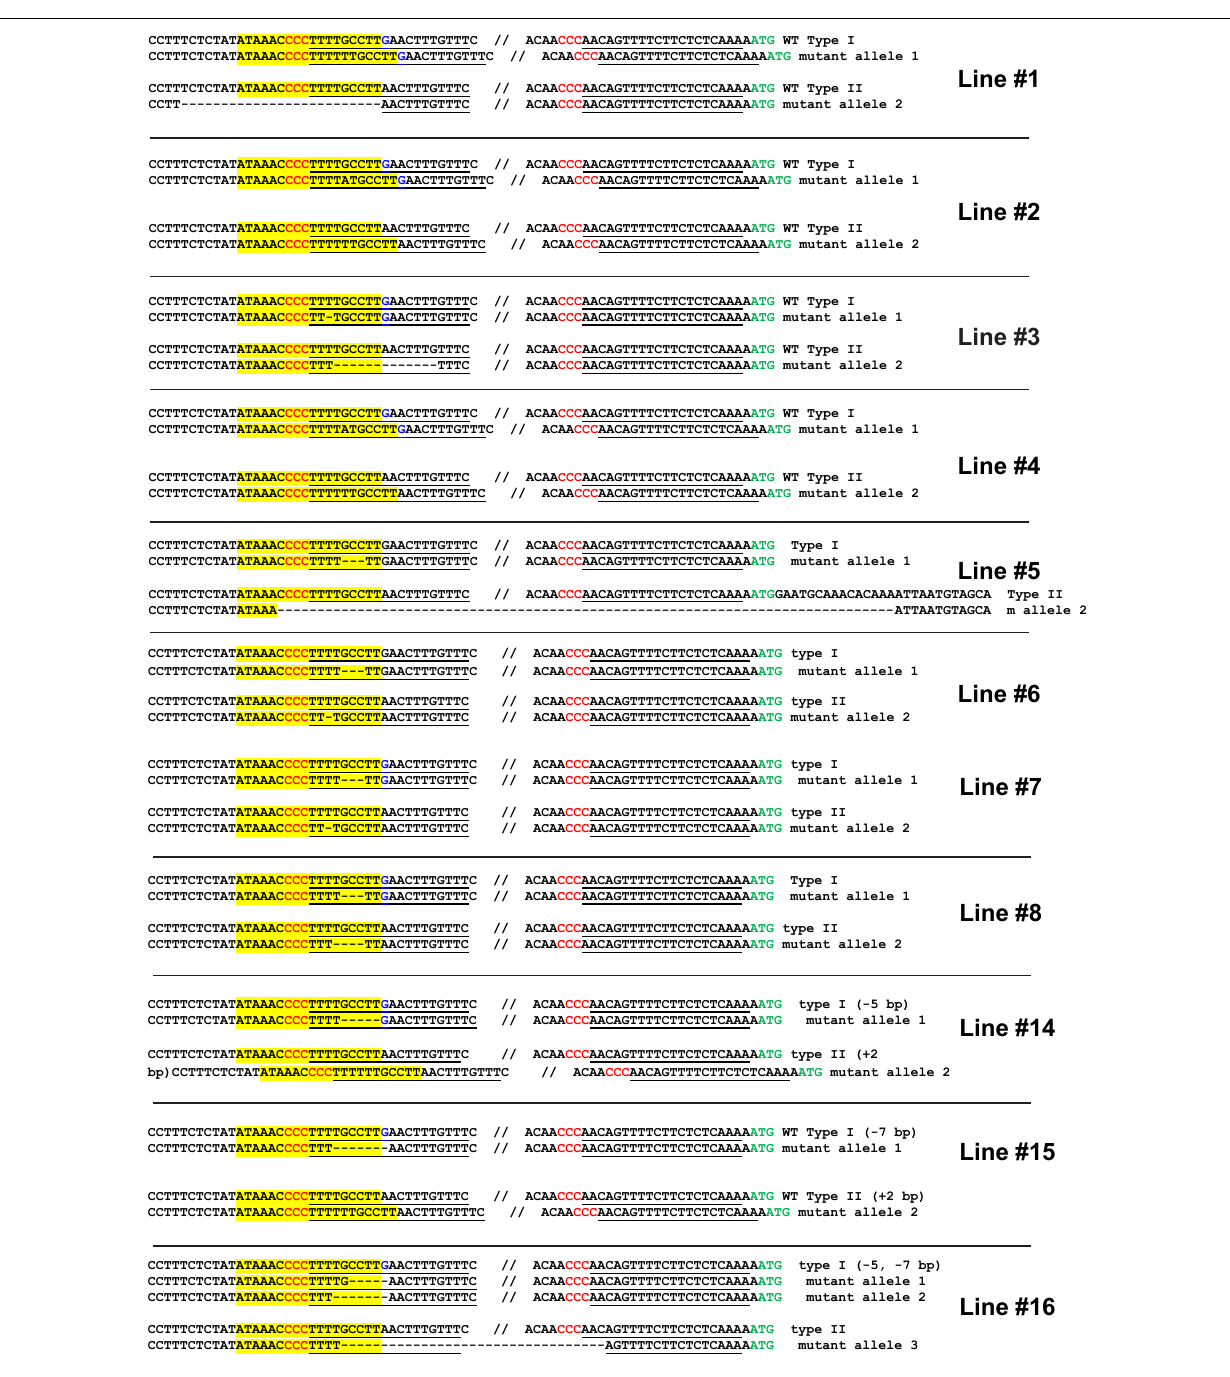
FIGURE 4 | Highly efficient generation of biallelic mutant citrus plants for Hamlin sweet orange. Genotyping of biallelic mutants. Mutations of the EBE region is the focus of the genotyping. The EBE region was highlighted with yellow; regions chosen for gRNAs were underlined; PAM was indicated in red; nucleotide G in blue is a SNP only in one allele, but not in another